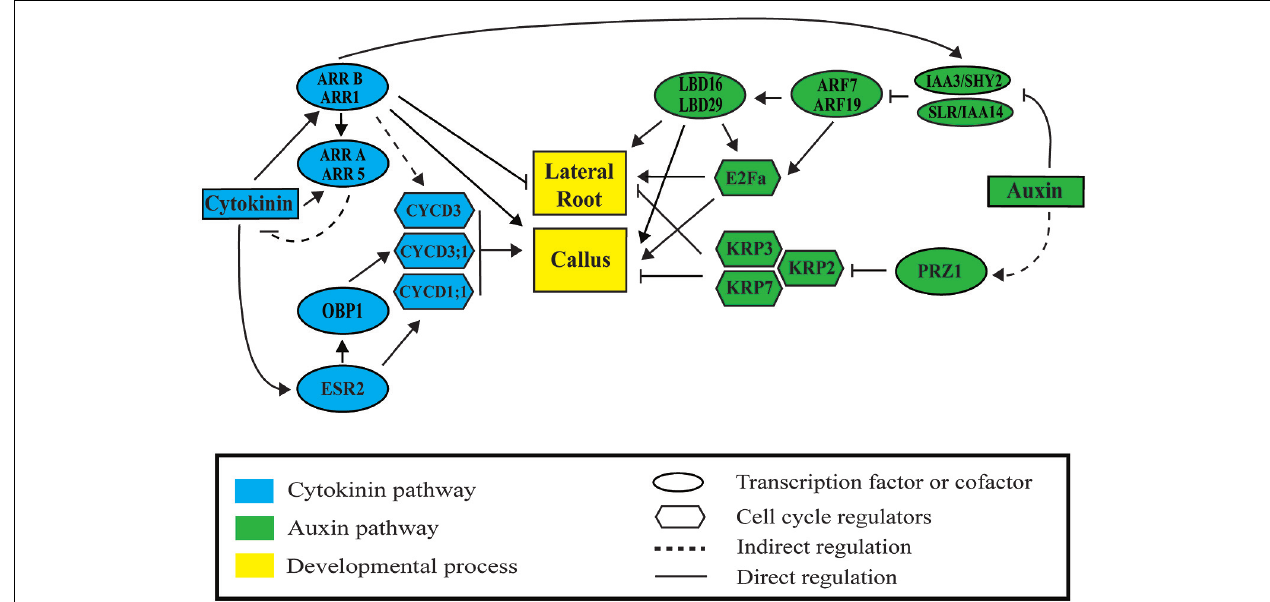
(ARR). Auxin and cytokinin regulate cell division through ARF-LBD factors, PROPORZ1 (PRZ1), ENHANCED SHOOT REGENERATION 2 (ESR2), OBF BINDING PROTEIN 1 (OBP1), and type B ARRs. Upon activation, downstream cyclin-dependent protein kinases D (CYCD), the transcription factor E2Fa, and the INHIBITORY PROTEIN (KIP)-RELATED PROTEINS (KRP) regulate progression through the cell cycle during lateral root and callus